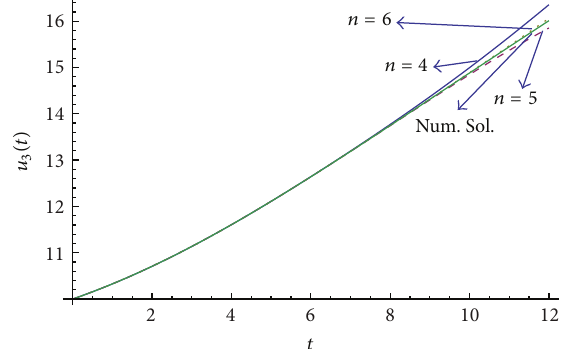
Figure 3: Comparison of iterations ( 𝑛 = 4, 5, 6 ) of PIA(1, 1) and numerical solutions for 𝑢 3